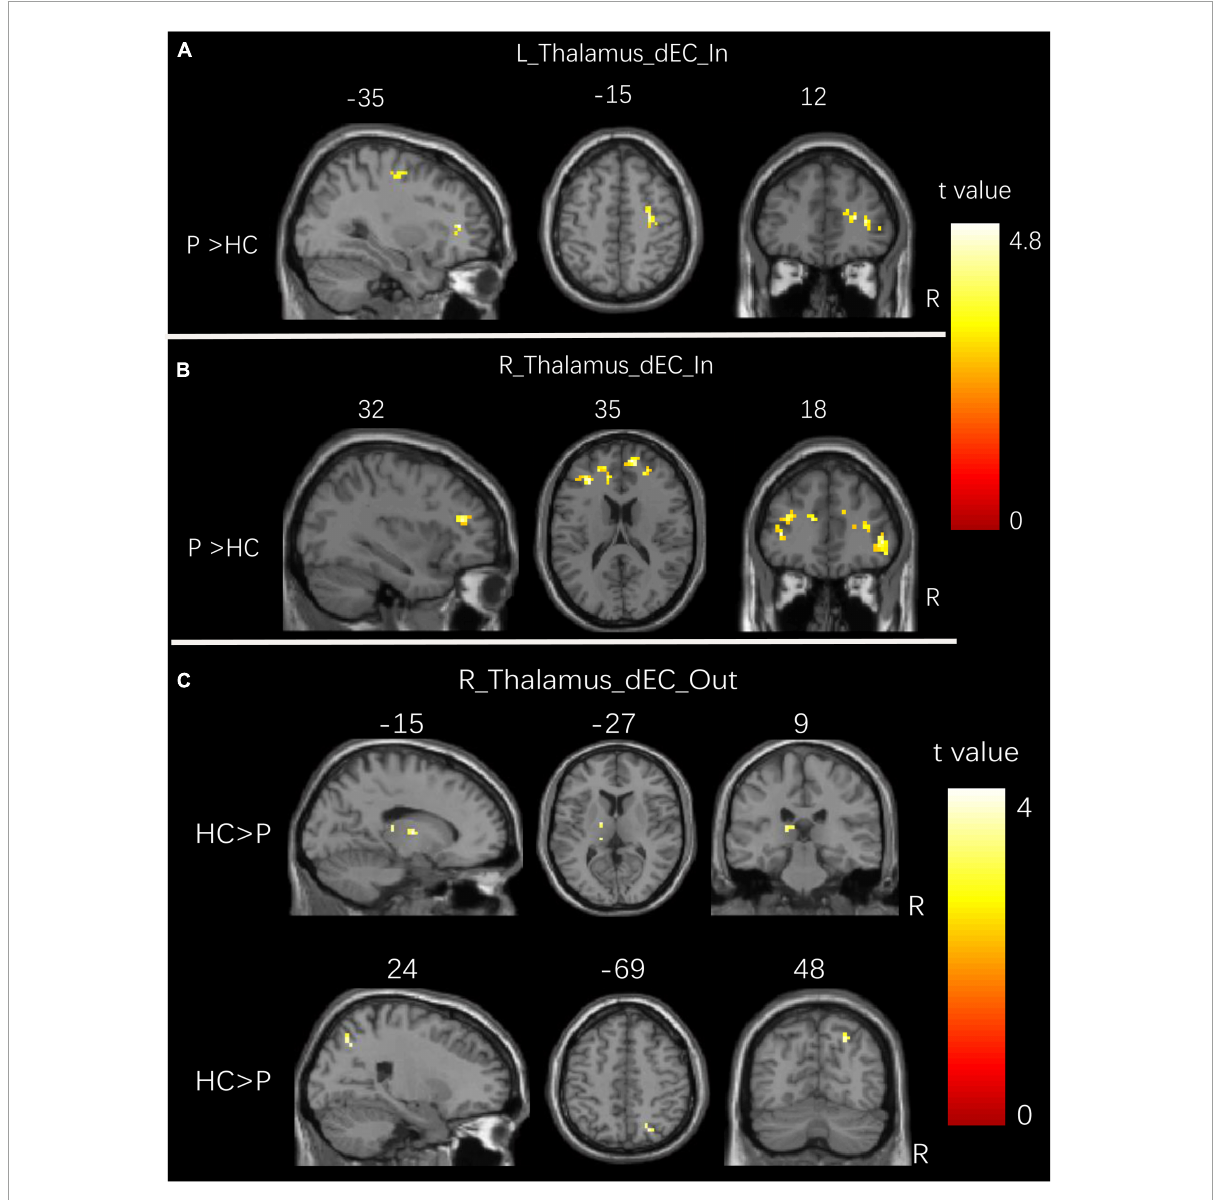
FIGURE3 Group differences in dEC variability for bilateral thalamus seeds between two groups. (A) Brain regions showing significant differences in dEC variability from the whole brain to the seed of the left thalamus. (B) Brain regions showing significant differences in dEC variability from the whole brain to the seed of the right thalamus. (C) Brain regions showing significant differences in dEC variability from the seed of the right thalamus to the whole brain. The comparison analysis was thresholded at p < 0.005, AlphaSim corrected. R, right hemisphere; L, left hemisphere. dEC, dynamic effective connectivity; HC, healthy controls; P, patients with generalized tonic-clonic